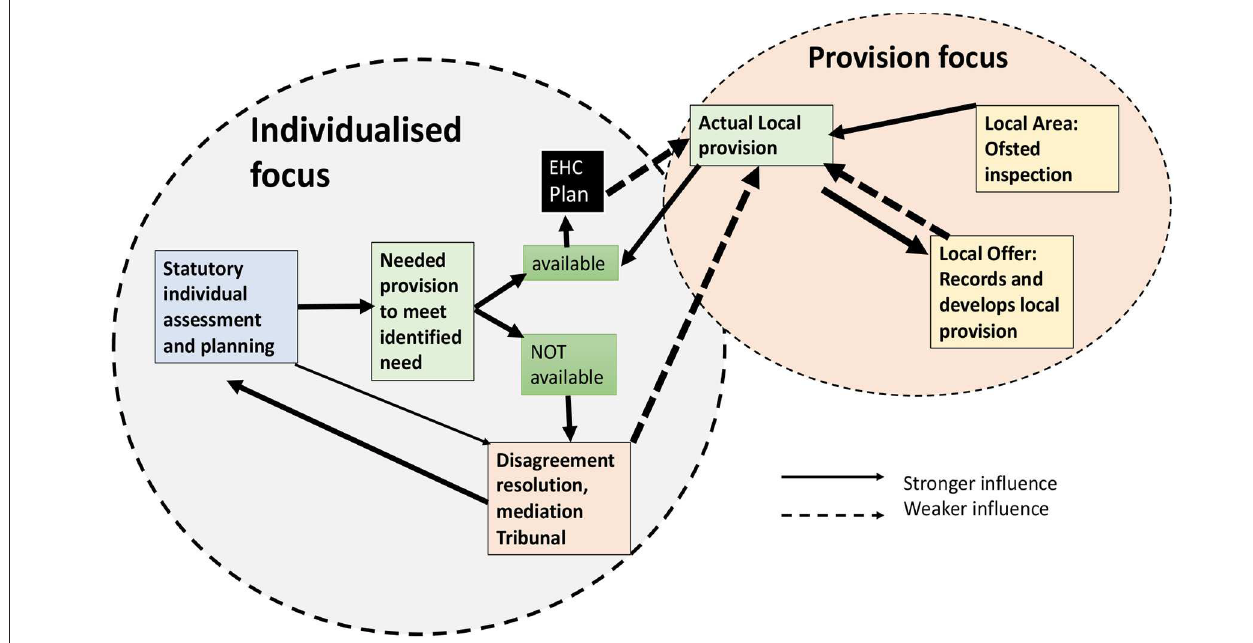
FIGURE 2 | The inter-relationship between an individualized and provision focused